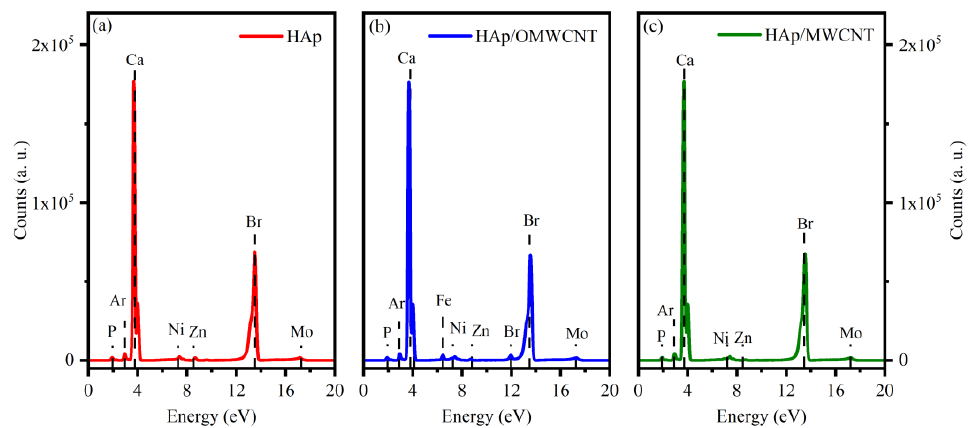
Figure 7. XRF spectra of the HAp ( a ), HAp/OMWCNT ( b ), and HAp/MWCNT ( c ) samples.